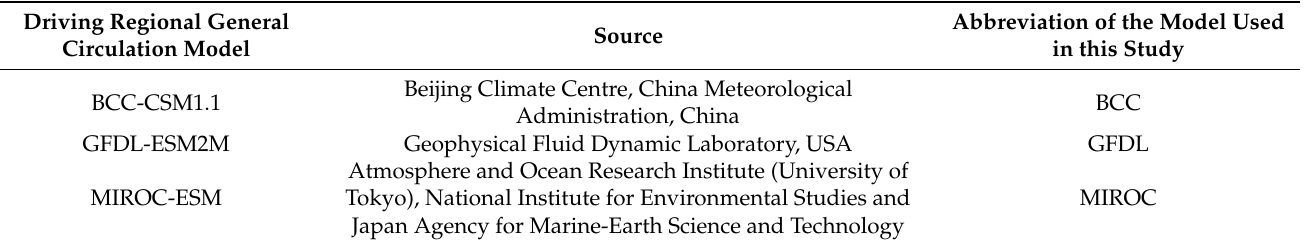
Table 1. List of driving GCMs and the model abbreviations used in this study. Driving Regional General Circulation